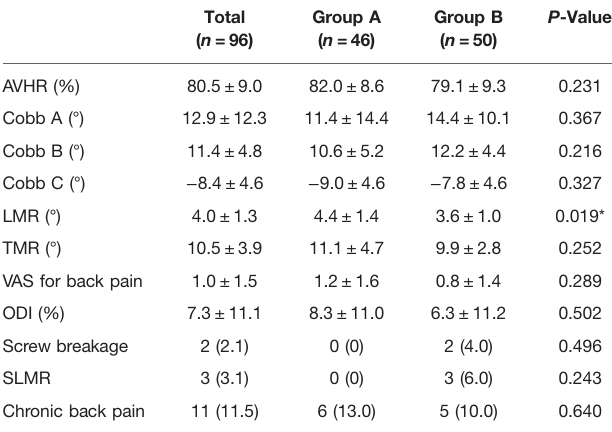
TABLE 2 | Clinical and radiological parameters before implant removal. TABLE 3 | Radiological and functional outcomes at the latest follow-up.